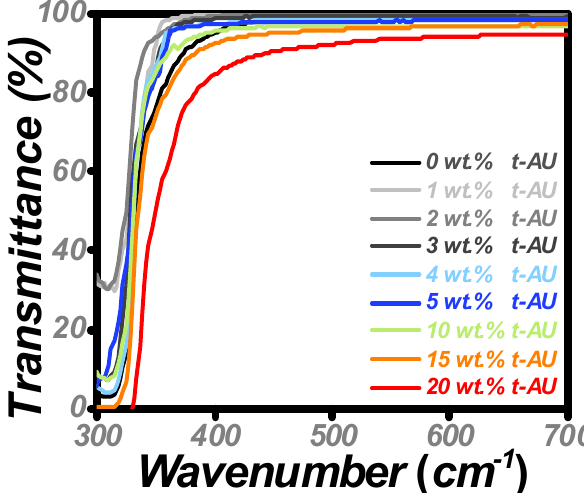
8 of 11 Figure 4. Gel rate ( A ) and average crosslink density ( B ) of AUP series based on a function of t-AU content. Table 3. Mechanical properties used to calculate the average crosslink density. Tensile Strength (MPa)